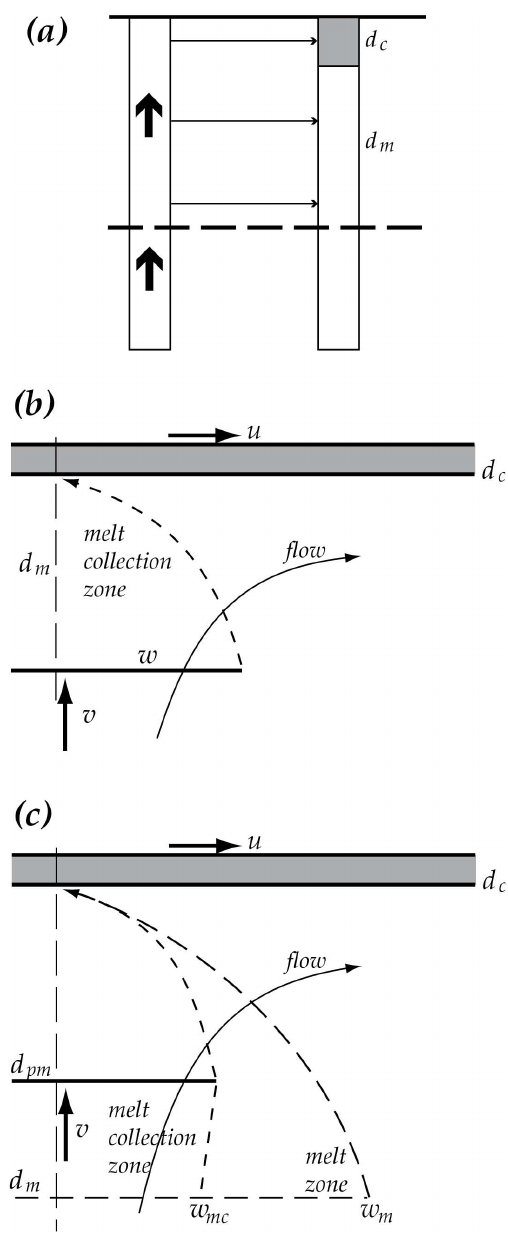
Fig. A1. Physical models of melting implicit in various formulae. (a) The column injection model implicit in the common formula relating melt fraction to thickness of oceanic crust. (b) A more re- alistic depiction of melting relationships in a homogeneous source, similar to Fig. 15a, involving two-dimensional flows of both the mantle and melt. (c) A depiction of melting relationships for a het- erogeneous source, similar to Fig.